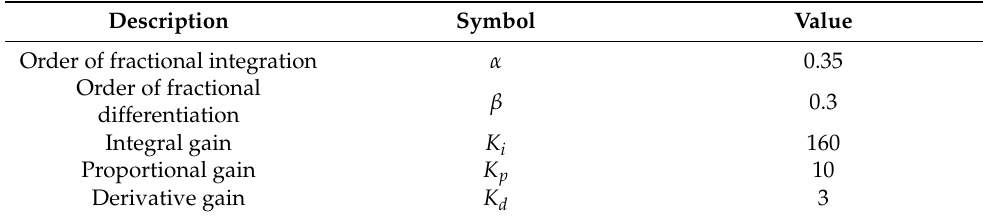
Table 2. Parameters of the FOSMC.